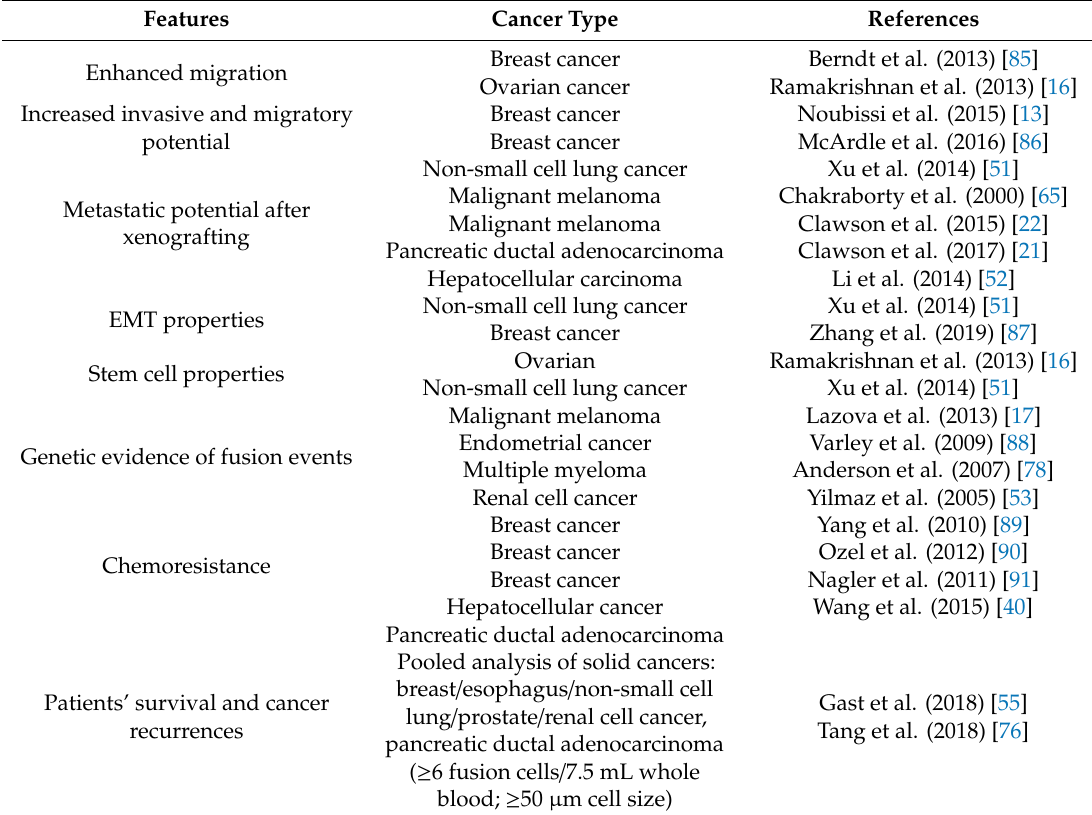
Table 3. Cancer-associated features associated with tumor cell